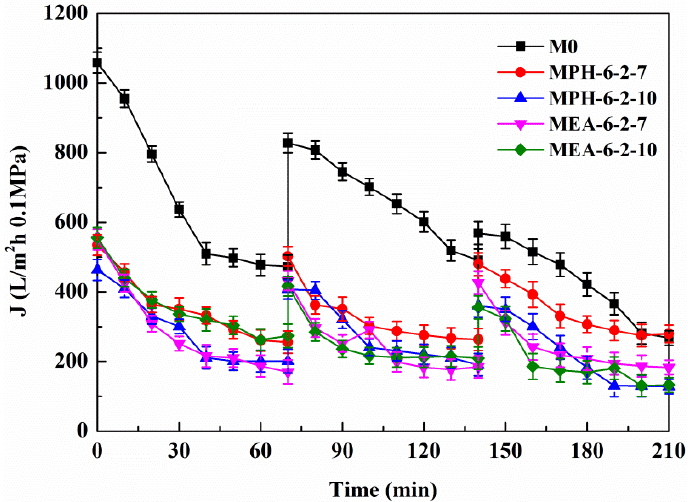
Figure 6. Permeate flux decline behavior of various membranes during cyclic filtration of a BSA